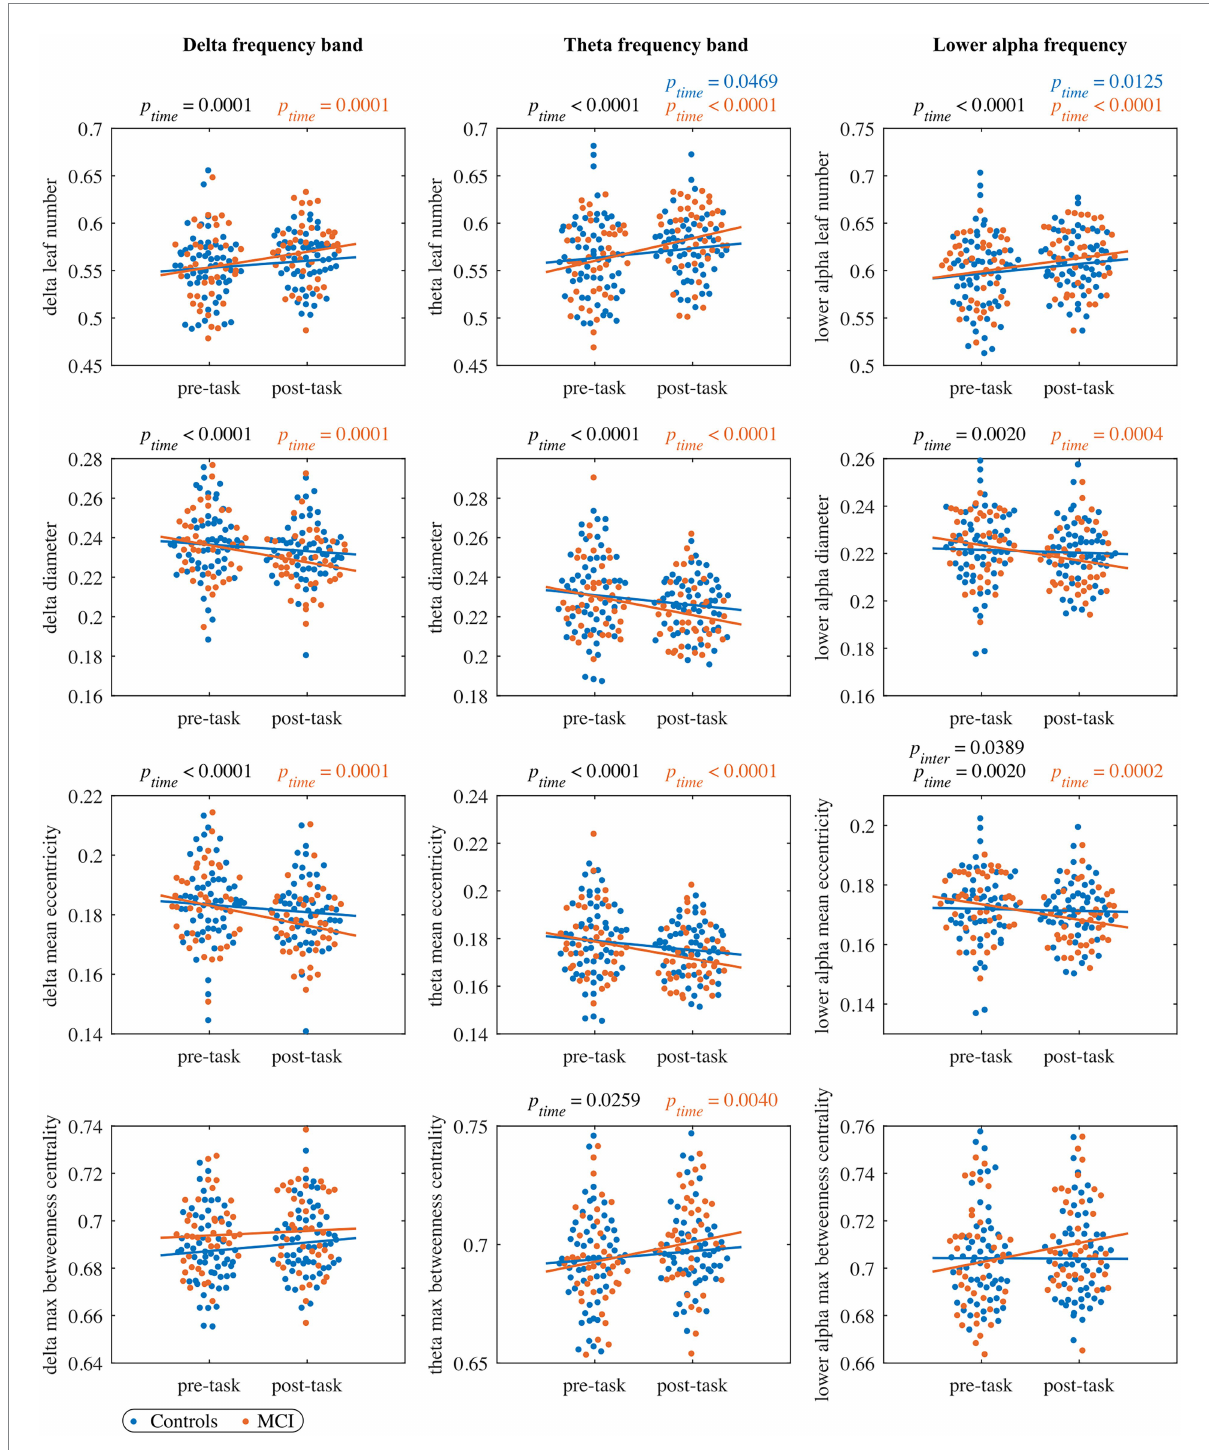
FIGURE 2 The pre- and post-task MST measures in the delta band (left column panels), theta band (middle column panels), and lower alpha band (right column panels). Each dot represents the value of one subject at pre/post-task timepoint (blue: control, orange: MCI). The black p time and p inter values indicate significant timepoint and interaction effects, respectively, of the LMM fitted to the whole cohort (no significant group effects were observed). The blue and orange lines represent the fit of the LMM fitted to the control and MCI group, respectively. The blue and orange p time values indicate significant timepoint effects of the LMM fitted to the control and MCI group, respectively. All the reported p values are FDR-